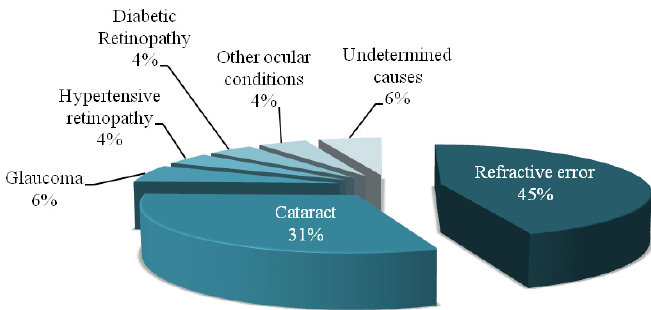
Figure 1 : Causes of visual impairment based on presenting visual acuity